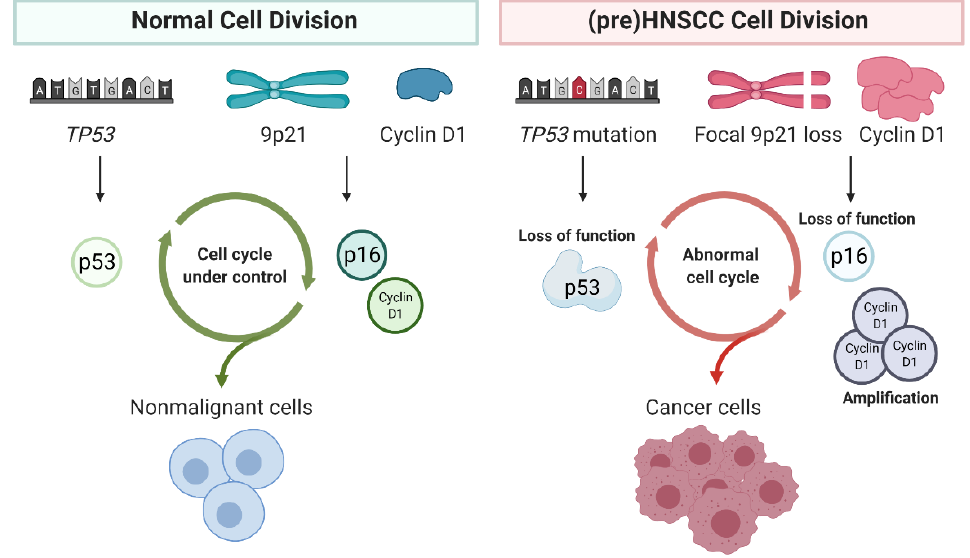
Figure 3. Cell cycle control in premalignant mucosal cells and HPV-negative HNSCC is impaired through frequent inactivation of p53 by (point) mutations. P16 Ink4A encoded by the CDKN2A gene at chromosome 9p21 is frequently inactivated by either mutations or promotor methylation, or focal homozygous losses of chromosome 9p21. Combined with the amplification of the CCND1 gene which encodes for cell cycle regulating protein cyclin D1, these alterations result in loss of normal cell cycle control and increase tolerance for DNA damage and aneuploidy as often observed in cancer cells.